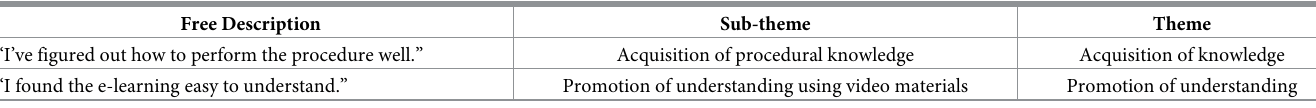
Table 3. Content analysis of pre-practice questionnaire about prior learning in the intervention group (n = 39). Free